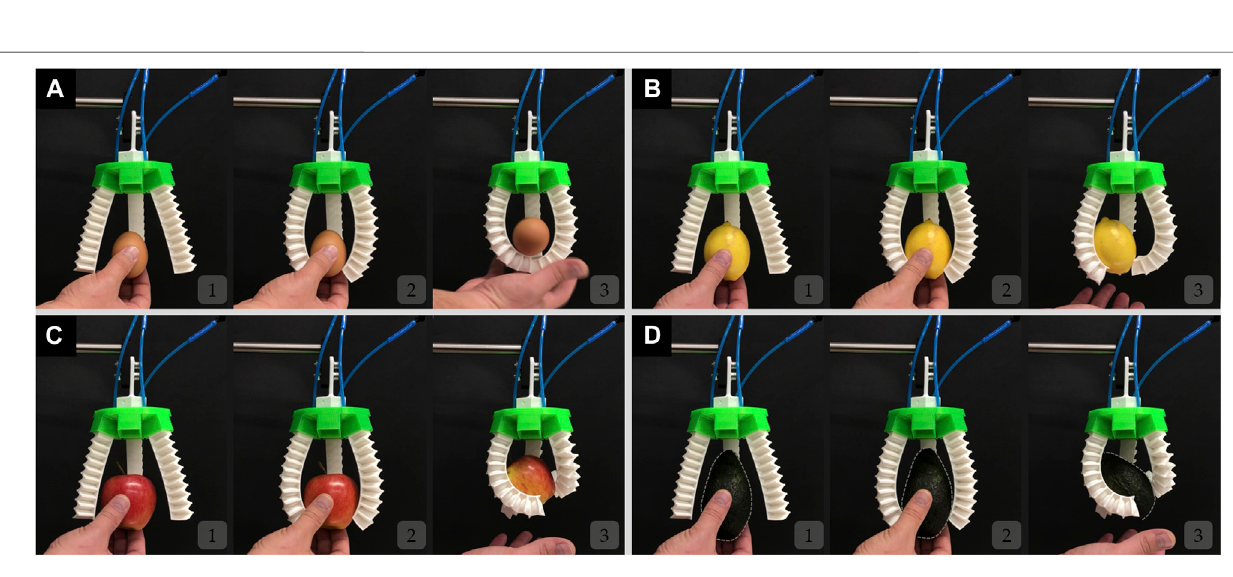
Frontiers in Robotics and AI |